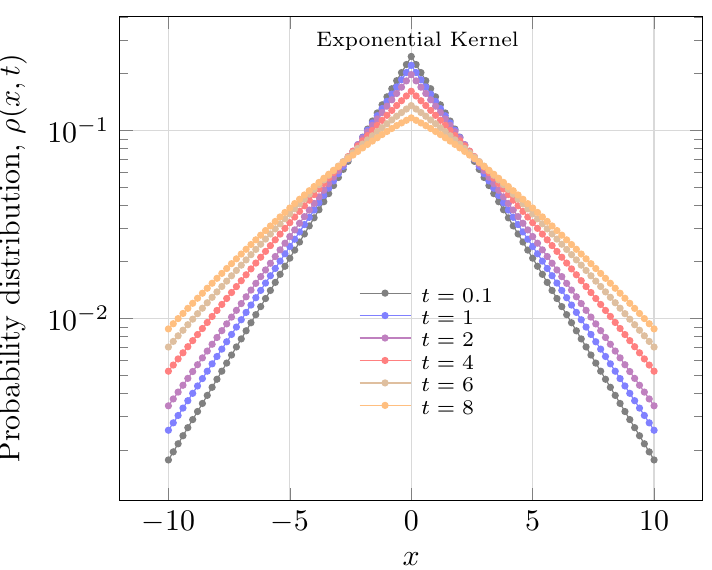
Figure 2. This curves illustrate the changes of distribution ρ ( x , t ) caused by the exponential kernel (Equation (3) in Equation (1)), considering ϕ ( x ) = δ ( x ) , 0.1,1,2,4,6,8 (in context of Caputo-Fabrizio operator α = 0.2 and { }